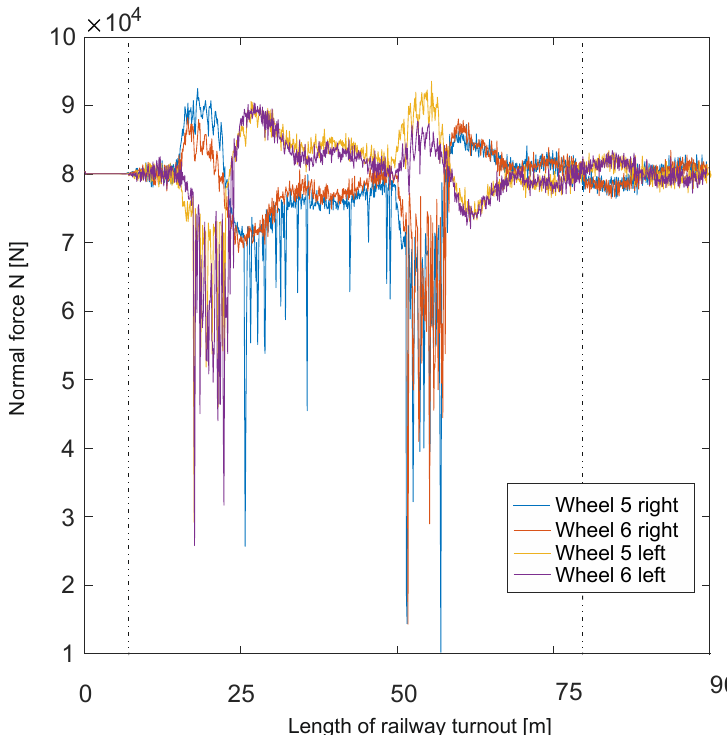
Figure 15. Normal force at 250 km/h on a straight track through a turnout.